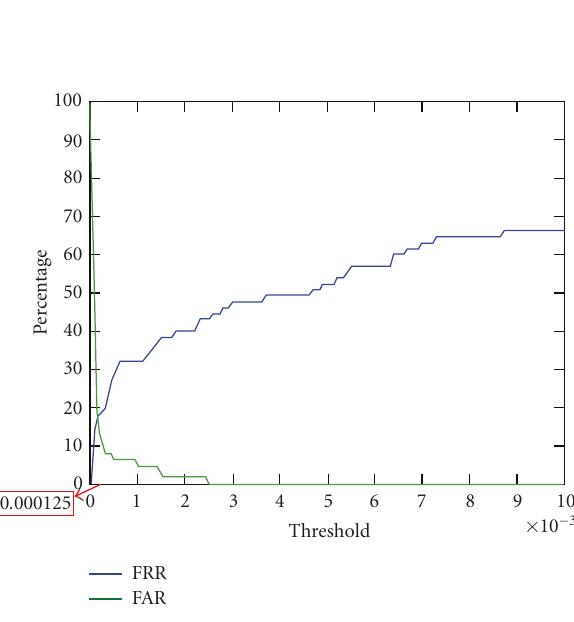
Figure 19: The performance of adaptive updating.